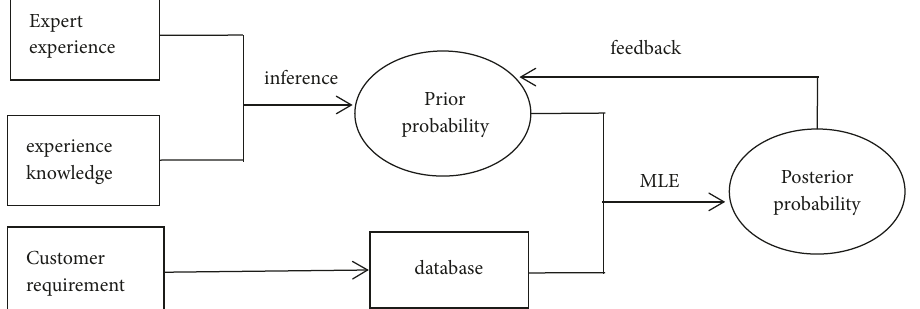
Figure 4: Parameter learning flow chart.